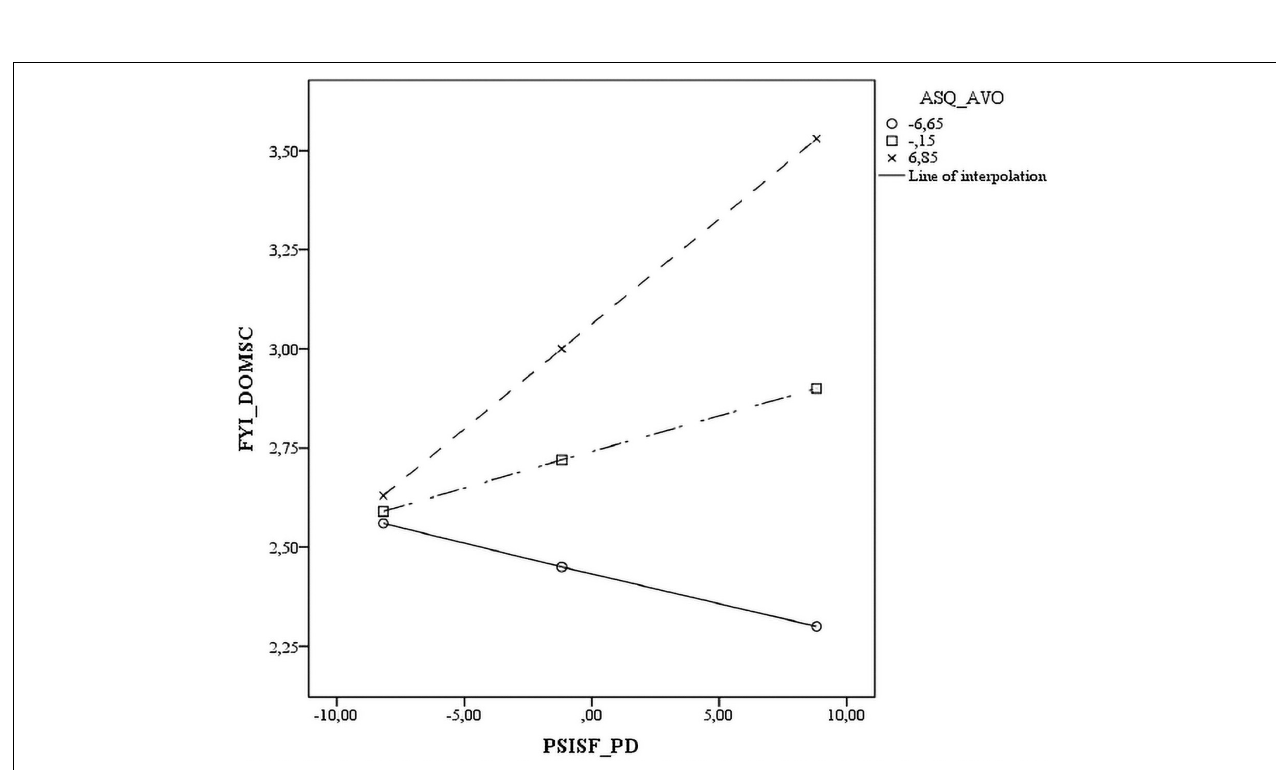
FIGURE 4 | Scatter plot of the interaction between avoidant attachment style and parental distress on the socio communicative domain.